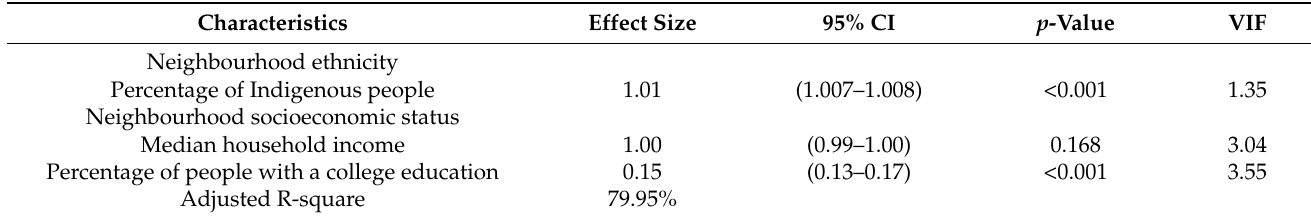
Table 2. Log-transformed age-standardized premature mortality regressed on neighbourhood SDOH using ordinary least squares model ( n = 349).